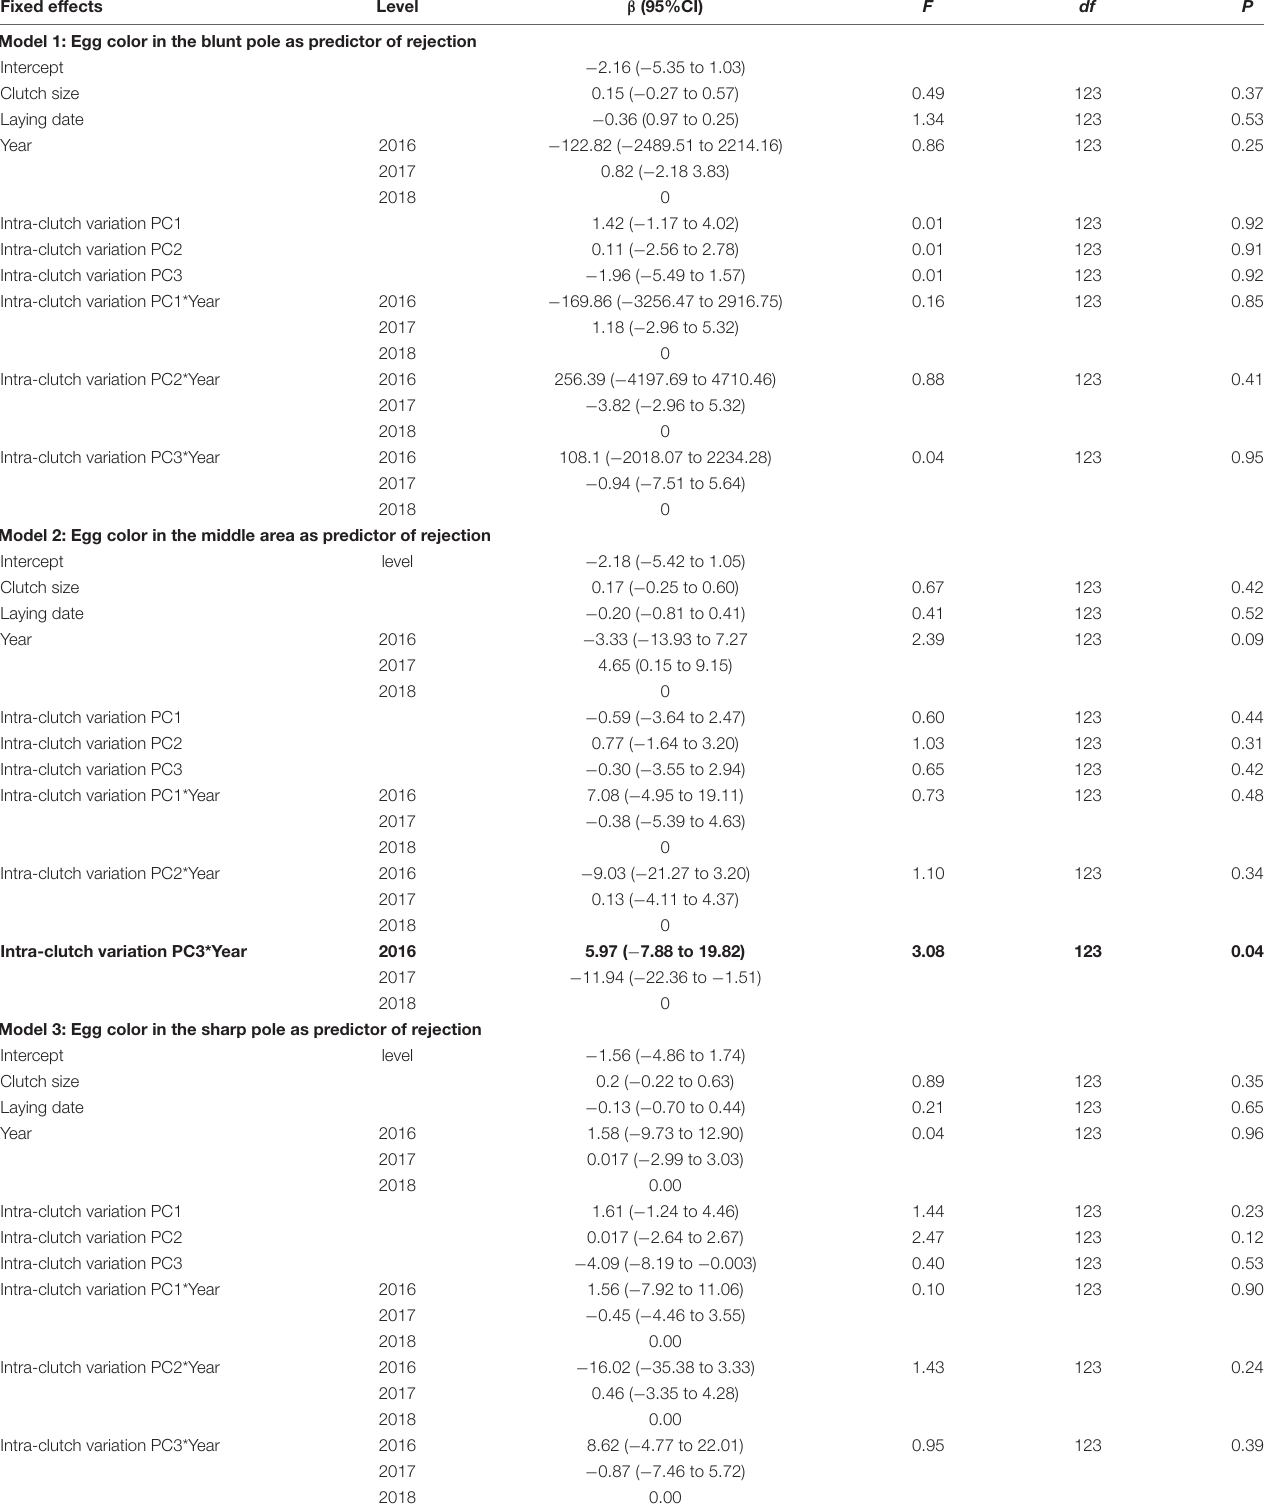
TABLE 2 | Intra-clutch variation in egg appearance in relation to rejection of model